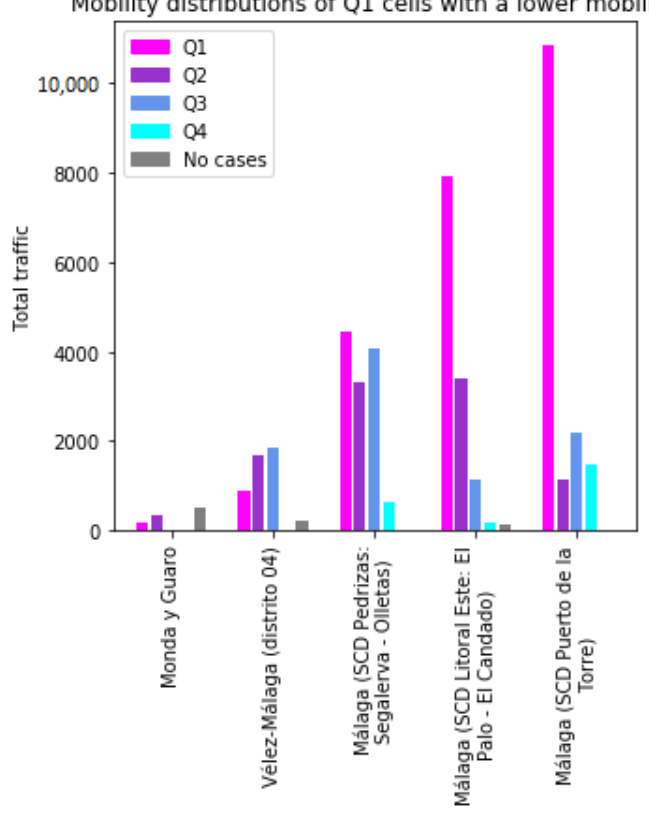
Figure 7. Traffic profiles for anomalous cells of Q1.